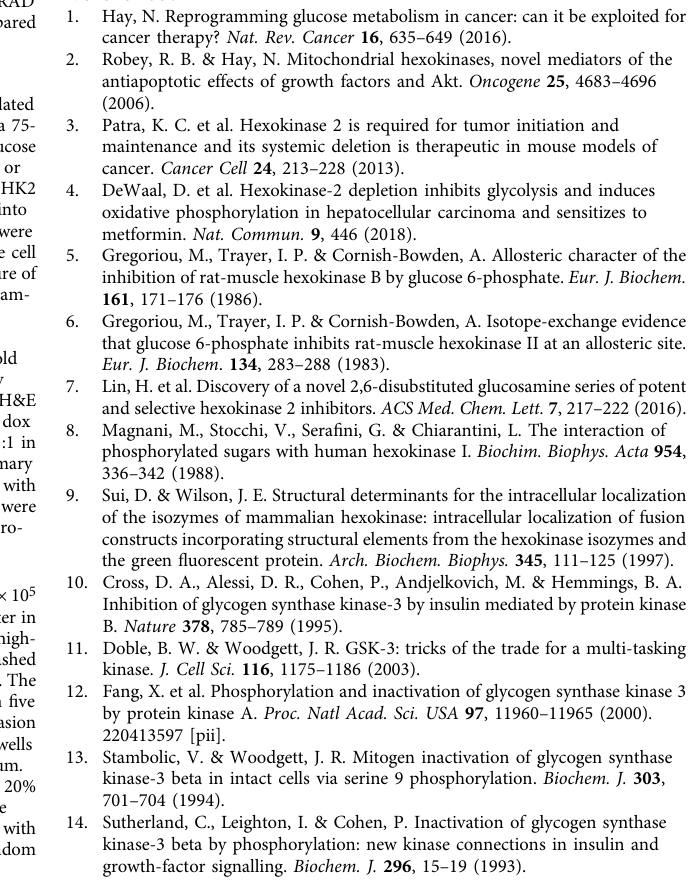
Antibodies: Supplementary Table 1 Recombinant Proteins: Supplementary Table 1 Chemicals and Enzymes: Supplementary Table 1 Commercial Assay Kits: Supplementary Table 1 Primers: Supplementary Table